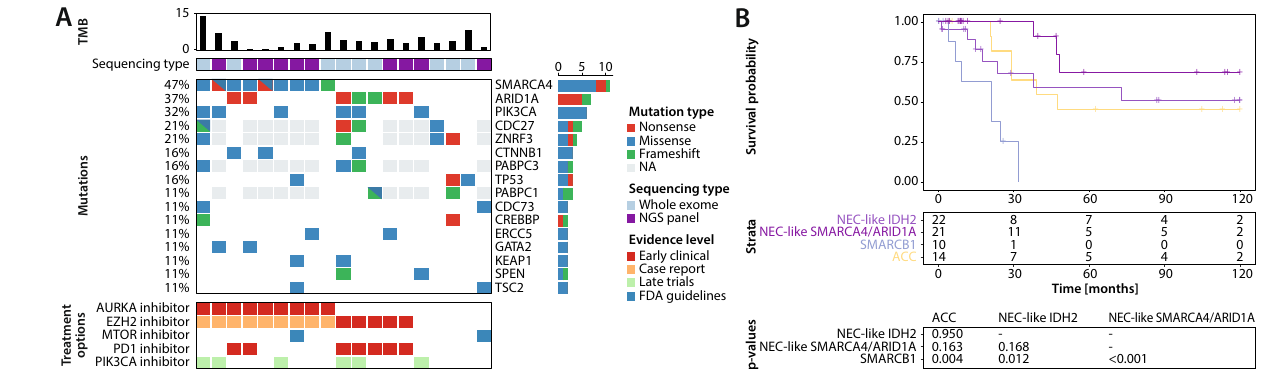
Fig. 4 | DNA sequencing results for NEC-like SMARCA4/ARID1A tumors and outcome analysis of sinonasal undifferentiated carcinoma (SNUC) DNA methylation classes. A The oncoprint plot shows tumor mutation burden (TMB) and recurrent mutations from whole exome sequencing or next generation panel sequencing(NGS).Potentialtreatmentoptionsandtheirrespectiveevidencelevels according to the classi fi cation from the Cancer Genome Interpreter website are shown in the panel below. B Overall survival Kaplan – Meier curve comparing disease-speci fi c survival rates in different SNUC DNA methylation classes. The